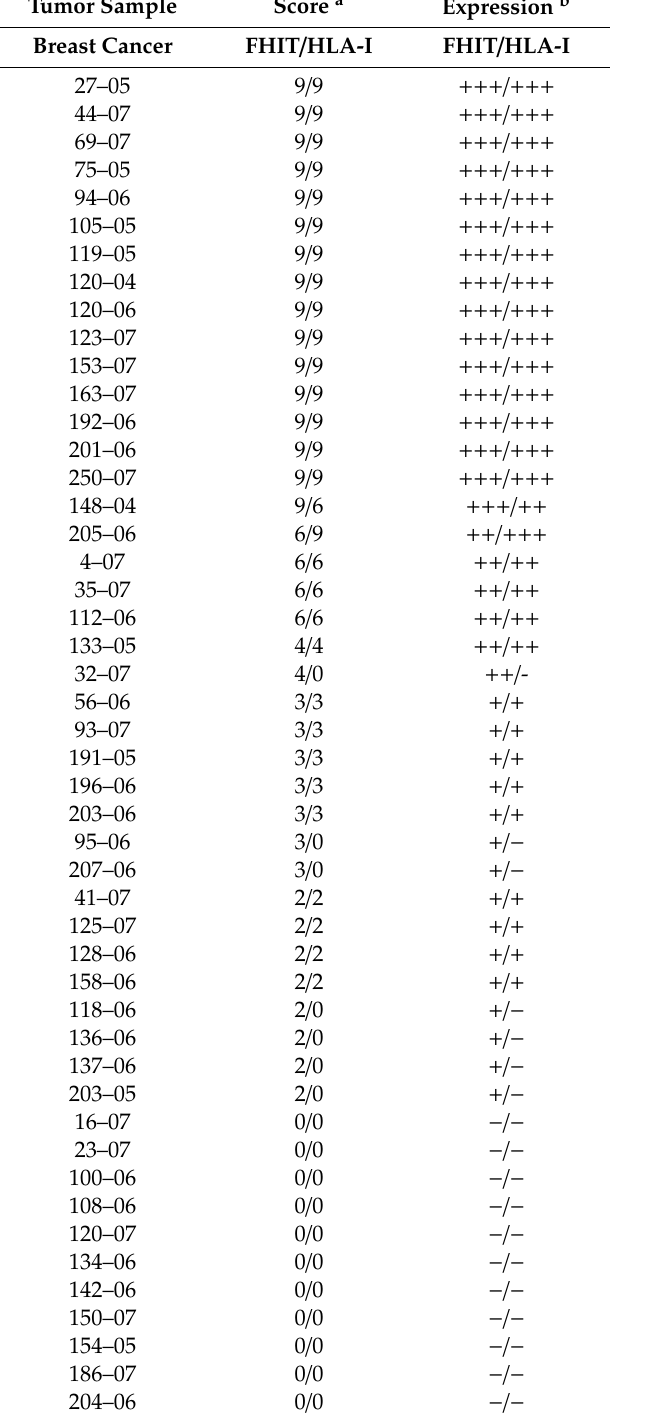
Table 2. FHIT and MHC-I expression in breast